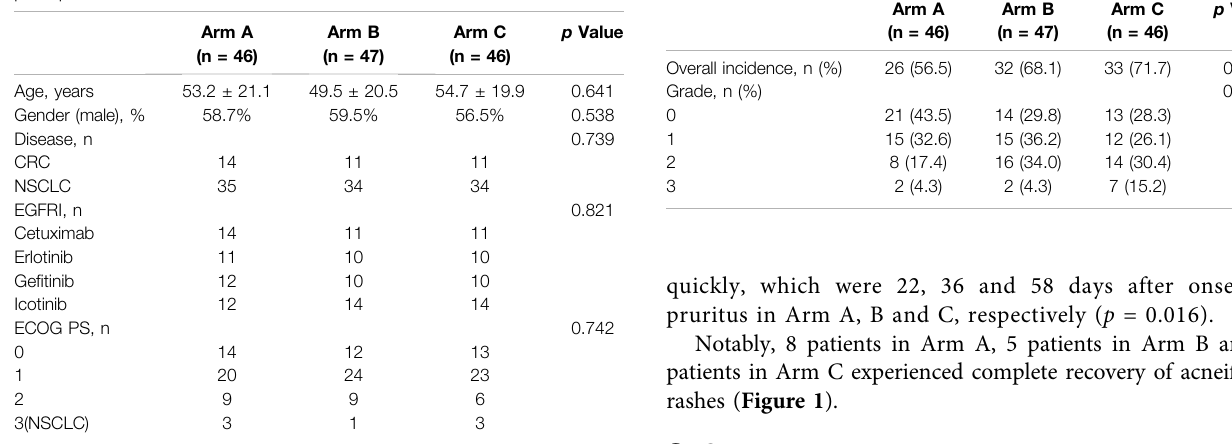
TABLE 1 | Demographic characteristics and baseline clinical parameters of the participants.